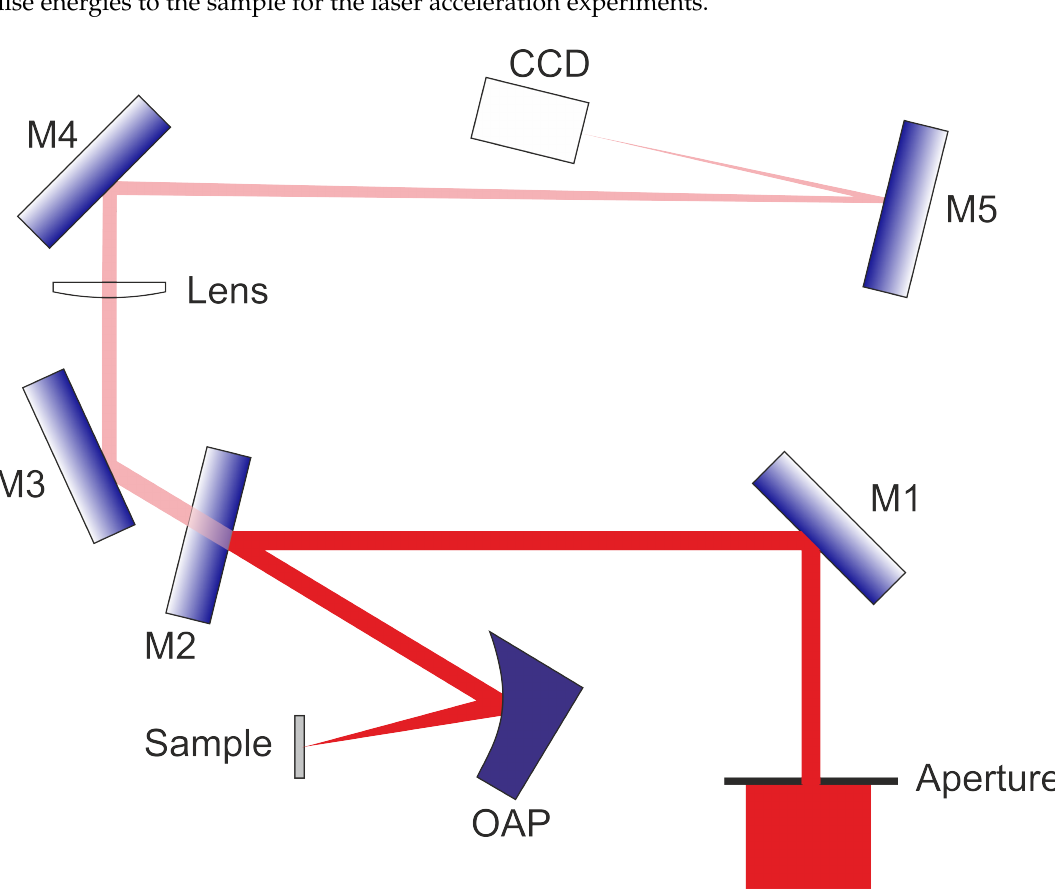
Figure 1. Experimental setup. Backscattered light from the target is collected by an off-axis parabola (OAP). Part of it is leaking through a mirror (M2) and is focused by a lens onto a CCD camera.